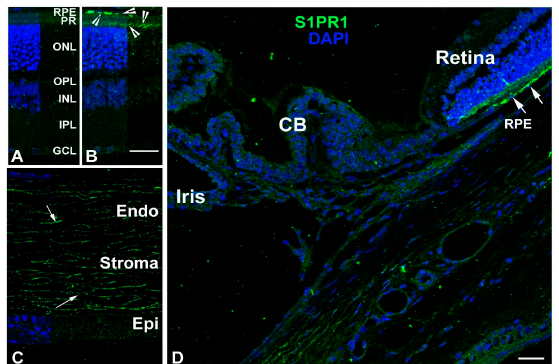
Figure 4. Localization of S1PR1 in adult (2–7 months old) rat ocular tissues. S1PR1 localization (green) was detected with anti-S1PR1 antibodies. ( A ) Rat retinal section in which the anti-S1PR1 antibodies were replaced with normal rabbit serum. The layers were marked and served as a negative control. ( B ) Retinal section of SD rat eye and S1PR1 localization in different layers is shown by arrowheads. ( C ) Corneal section of SD rat eye with S1PR1 labeling. ( D ) Partial anterior segment of eye containing ciliary epithelial cells, trabecular meshwork and Schlemm’s canal. S1PR1 localization is shown by arrowheads. RPE, retinal pigment epithelium. PR, photoreceptor. ONL, outer nuclear layer. OPL, outer plexiform layer. INL, inner nuclear layer. IPL, inner plexiform layer. GCL, ganglion cell layer. Endo, endothelium. Epi, epithelium. CB, ciliary body. Scale = 25 µ